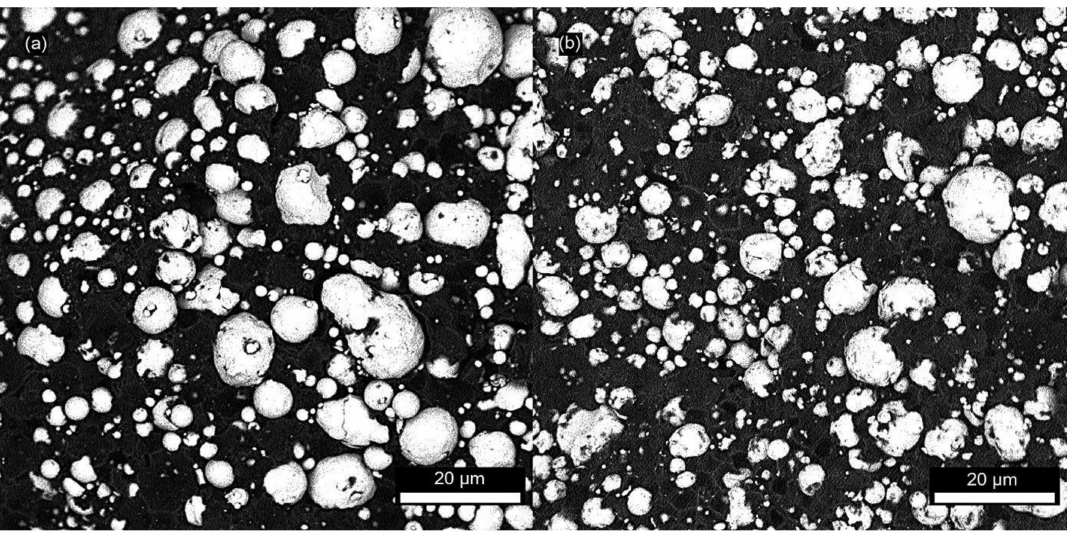
Figure 1. SEM micrograph of: ( a ) acrawax (AW) based feedstock; ( b ) carnauba wax (CW) based